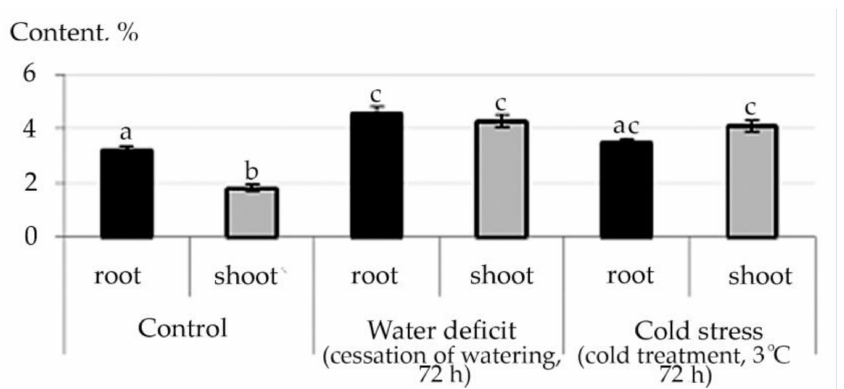
Figure 13. Change in content of Squalen in R. semenowii under stress conditions. Values presented are means ( ± SD). Different letters above the bars represent significant differences at p ≤ 0.05, n = 3 plants in each of 3 replicates for all